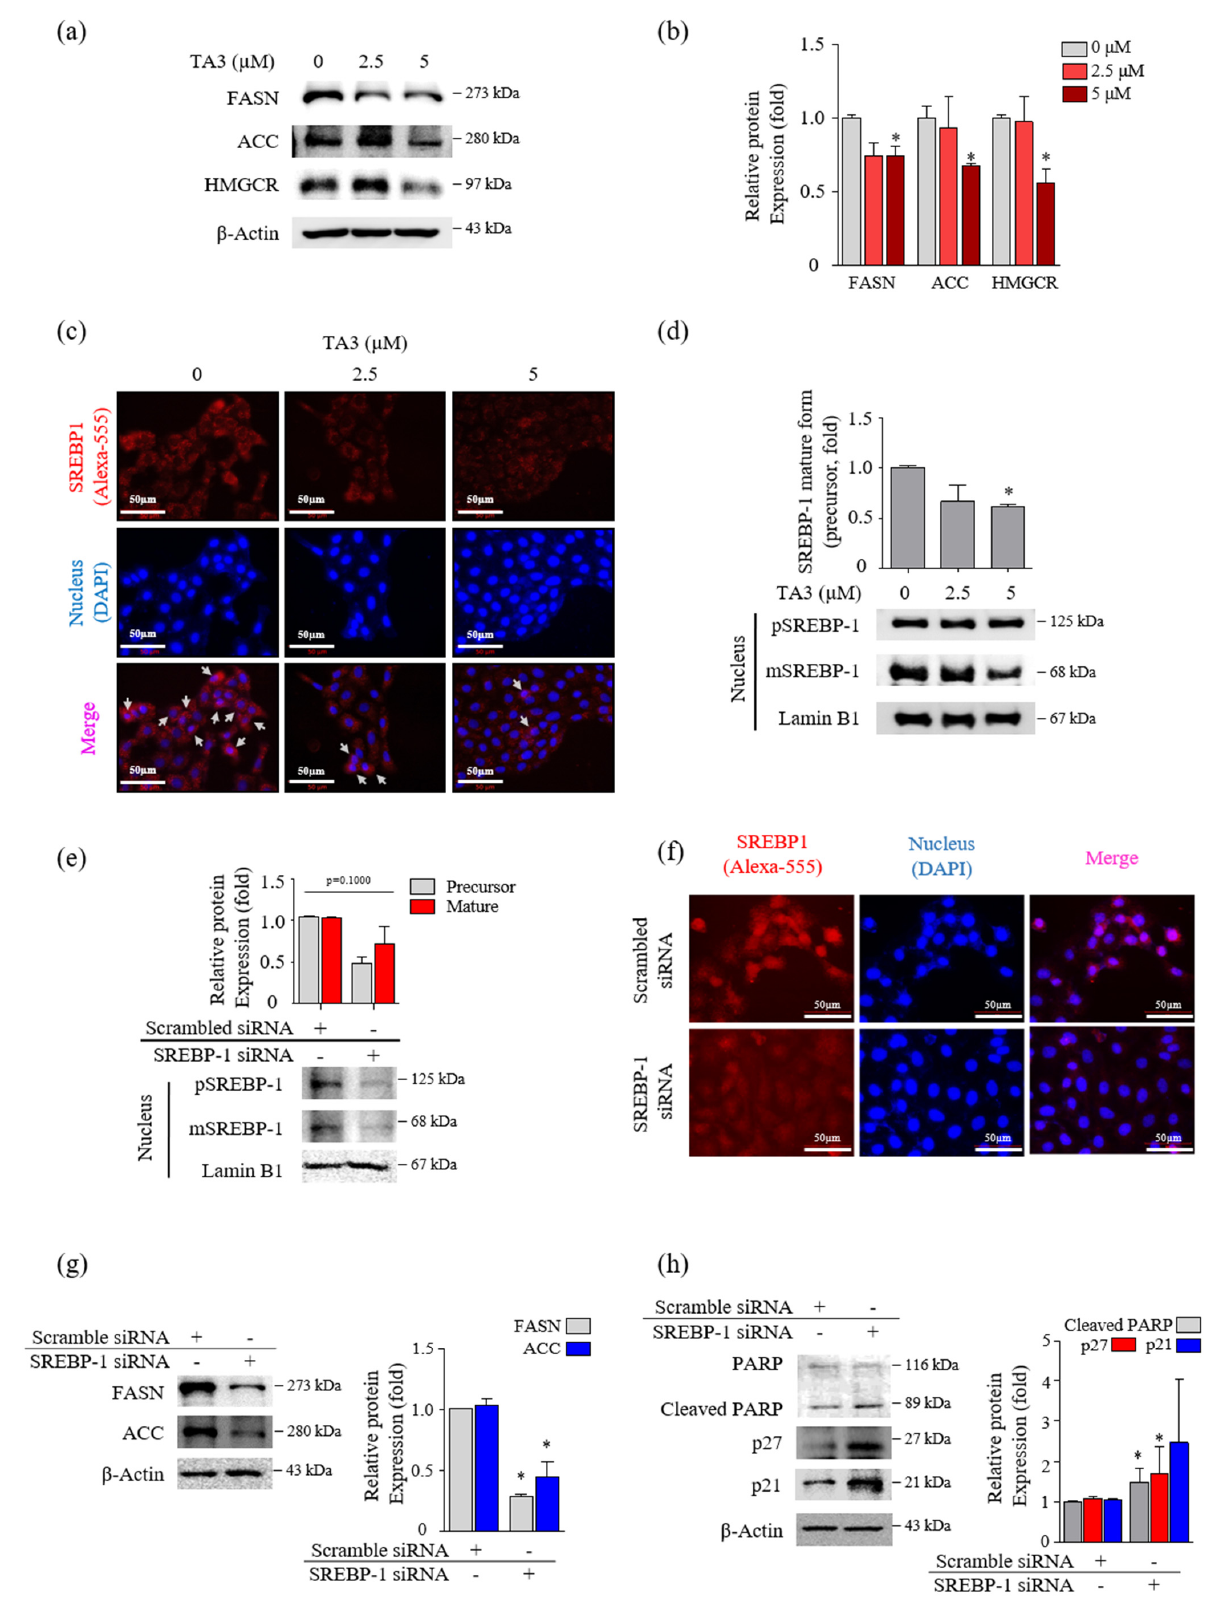
Figure 2. TA3 reduced the nuclear localization of mature SREBP-1, which inhibited the lipogenic enzymes and cell growth in BxPC-3 cells. ( a – d ) The effect of TA3 treatment for 12 h on